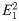
Resulting learned sequences in all the experts.It can be seen how the output projections to yi(t) help to adaptively compress predictable parts of the input. The higher in the hierarchy, the lower the order of the Markov chain the Experts process. On the top of the hierarchy, the order is 1 and for the Expert E12 the sequence of hidden states has a linear structure.